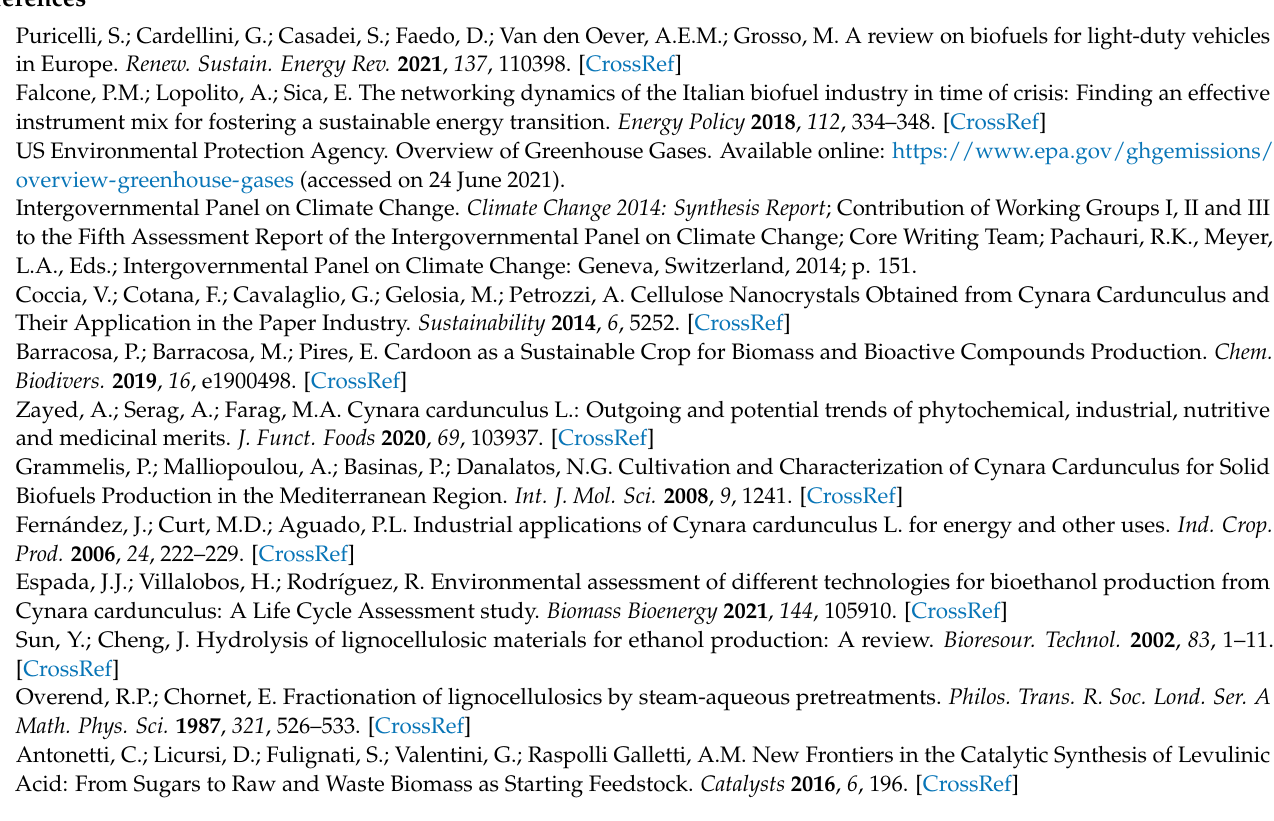
assignments, see Table S2, Figure S6: XIC chromatogram obtained from selected compounds of interest, according to Ib á ñez et al. For numbering and corresponding assignments, see Table S3, Figure S7: Monomeric/oligomeric (as dimeric/trimeric) compounds of 5-HMF and corresponding XIC chromatogram, Figure S8 and Table S1: Chromatographic data of the main detected compounds reported in Figure S4, Table S2: Chromatographic data of selected compounds of interest for hy- drolyzates of biomass source, according to Gli´nska et al. (see also XIC chromatogram of Figure S5), Table S3: Chromatographic data of selected compounds of interest for hydrolyzates of biomass source, according to Ib á ñez et al. (see also XIC chromatogram of Figure